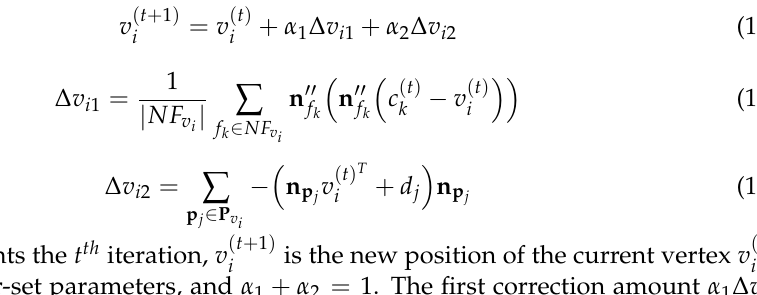
Figure 9. Variation in the local sharp edge e ij display of the sharp edges; ( b )–( d ) 2D representation of the dihedral angle changes; ( b ) the original state in ( a ); ( c ) the dihedral angle of edge e ij weaker; and ( d ) the dihedral angle of the edge e ij